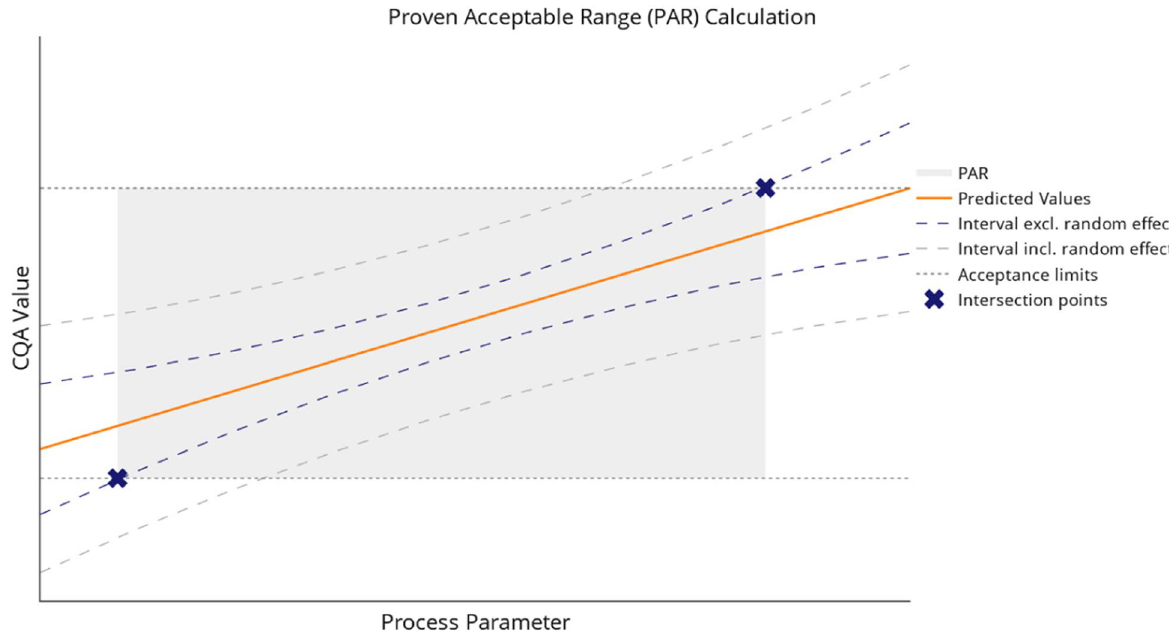
Fig. 1 An example for how the PAR of a process parameter can be calculated. The intersection points of a statistical interval and the CQA acceptance criteria define the lower and upper boundary. Note that the PAR that ignores the random effect is larger than the one that incorporates the random nature of the